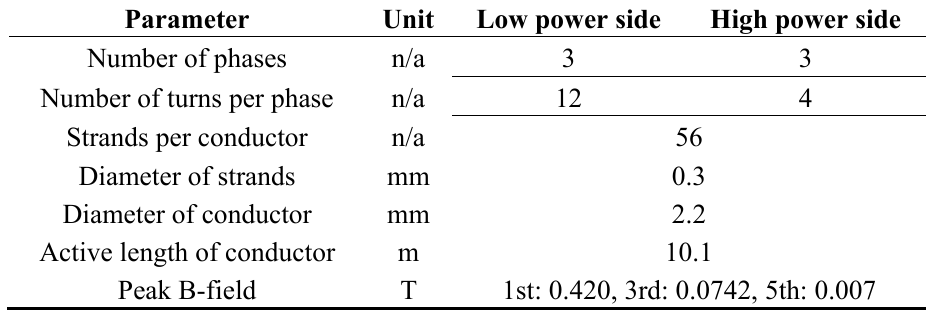
Table 8. Parameters of the windings of the flywheel electric